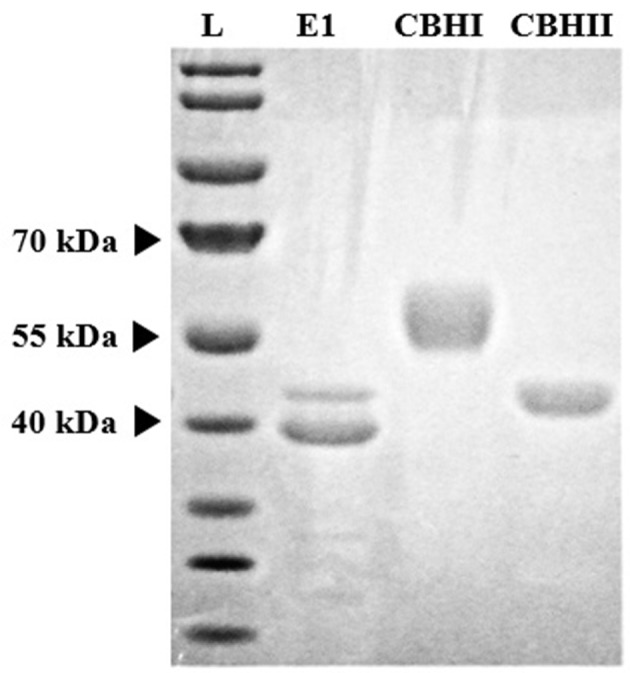
Coomassie Blue stained SDS-PAGE gel of three recombinant cellulolytic enzymes purified from corn grain expression system. Lane L is the standard protein ladder.